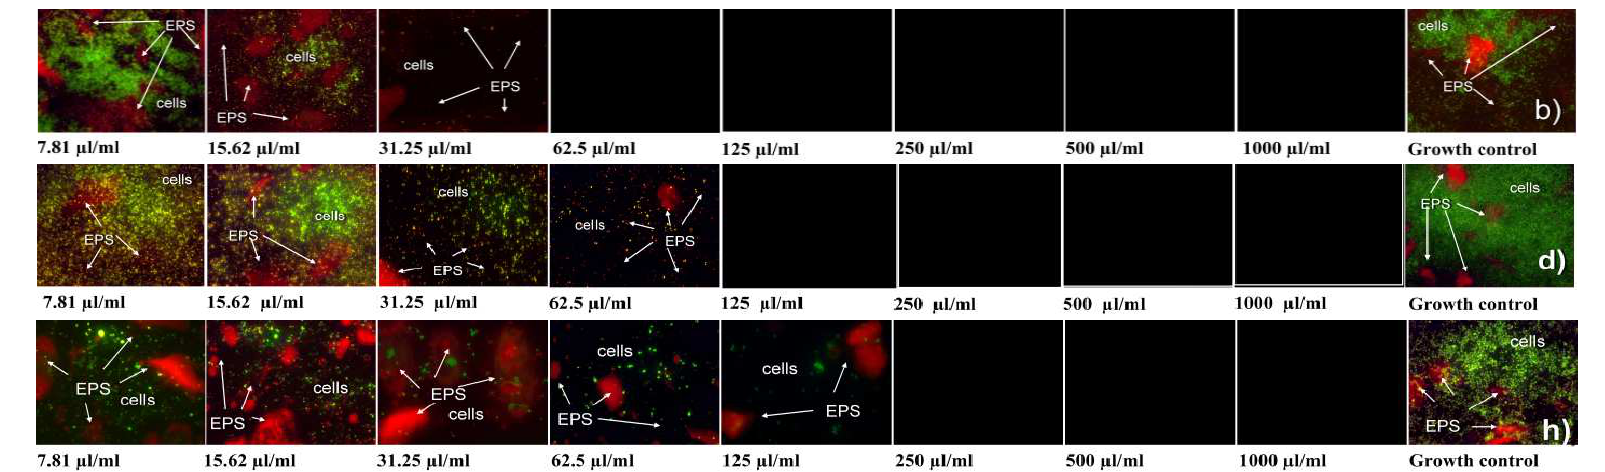
Figure 3. Influence of the test substance 3 on biofilms b) b) E. coli PMFKG-F2, d) P . mirabilis PMFKG-F4, h) S. cerevisiae PMFKG-F6. EPS – Extracellular polymer substance.